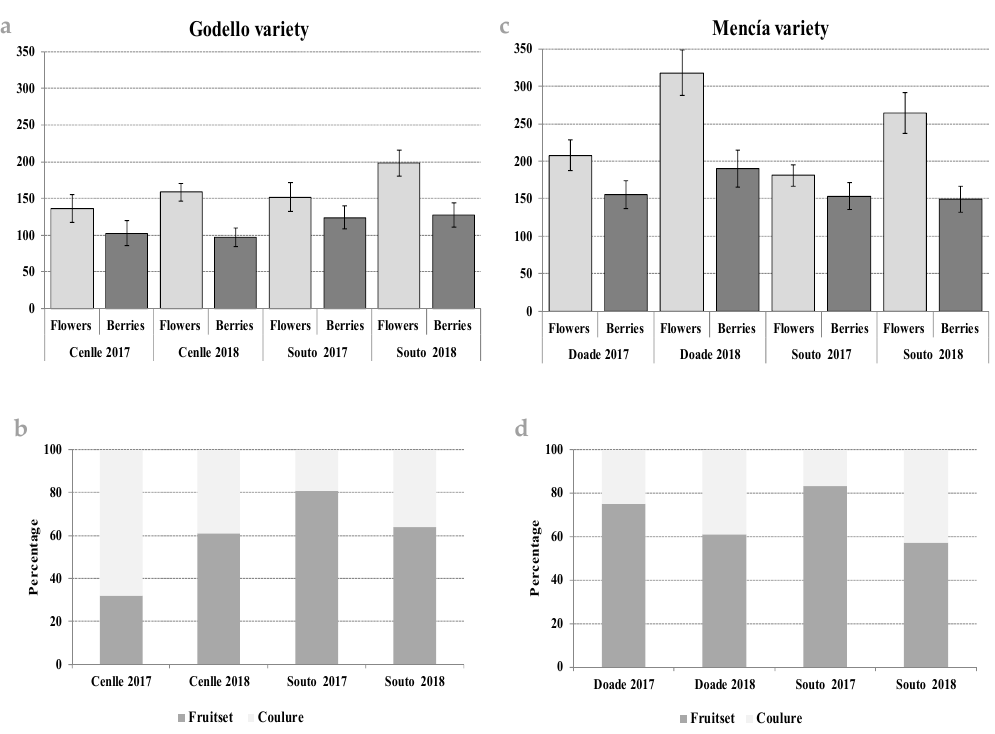
Figure 3. Average values of flowers and berries in sampled bunches for Godello (a) and Mencía (c) . Fruitset %, and coulure % index for the Godello (b ) and Mencía (d) varieties, in the studied vineyards during 2017 and 2018 (standard error of the mean on each column).